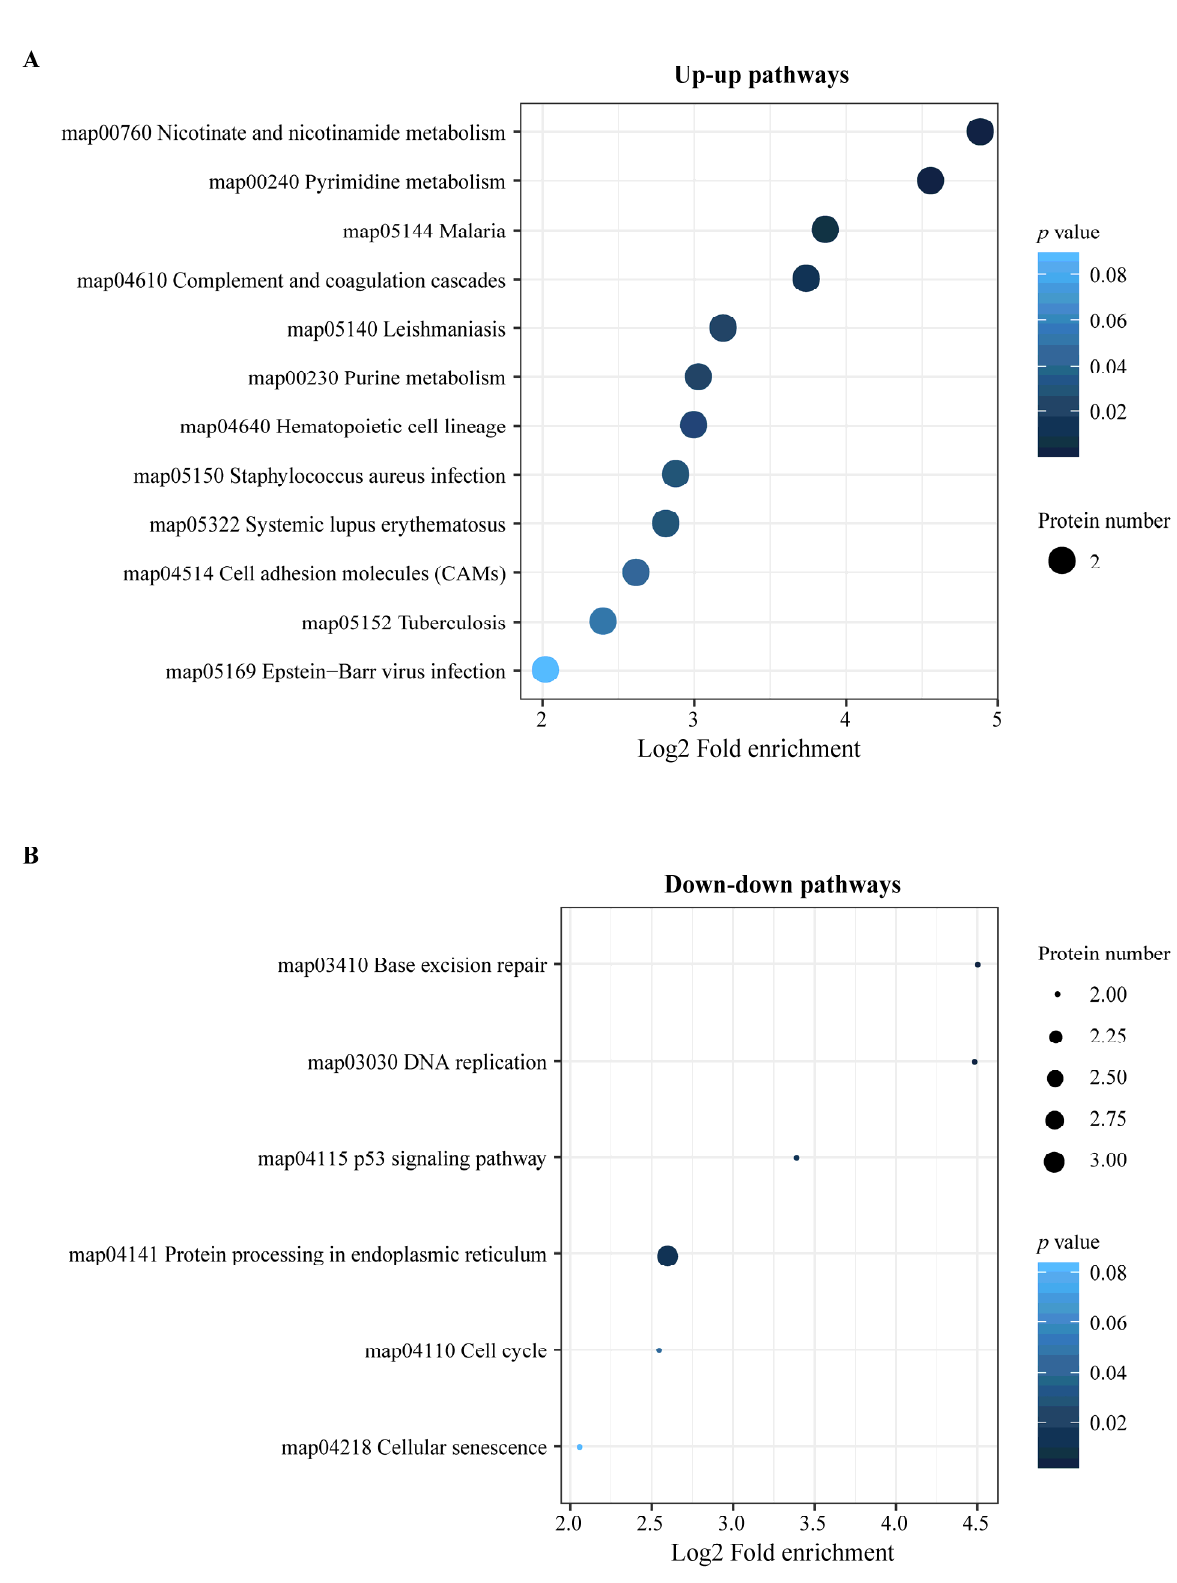
Figure 9. KEGG pathway enrichment analysis of cor-DEGs-DEPs in E515- Bb vs. Bb . ( A ) Up-up pathways. ( B ) Down-down pathways. The X-axis represents the value of Log2 fold enrichment. The Y-axis represents the enrichment term of pathway. The size of the dot represents the number of DEPs. The color represents p value.